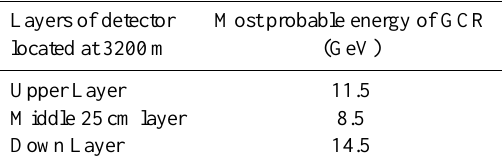
Table 5. Modes of the GCR energy spectra corresponding to differ- ent species of secondary particles registered by the SEVAN detector at 3200m above sea